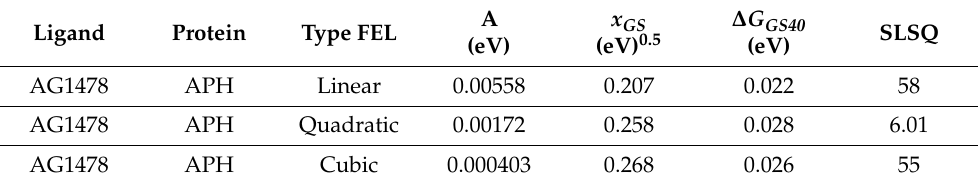
Table 4. Fit photophysical parameters for ligand from the REES curve. (Reorg denoted reorganization energy, other parameters/symbols are defined in the main text) ∆ G ∆ G x CT Reorg CTGS 0 CTGSN Ligand Protein Type FEL (eV) (eV) (eV) 0.5 (eV) AG1478 APH Quadratic 3.172 3.015 1.076 0.579 Table 5. Fit parameters for REES curve according to different thermodynamic models. (SLSQ refers to the sum of least-squares, a measure of the quality of the model fit to the experiment). x GS A Ligand Protein Type FEL SLSQ (eV) (eV) 0.5 (eV) APH Linear APH